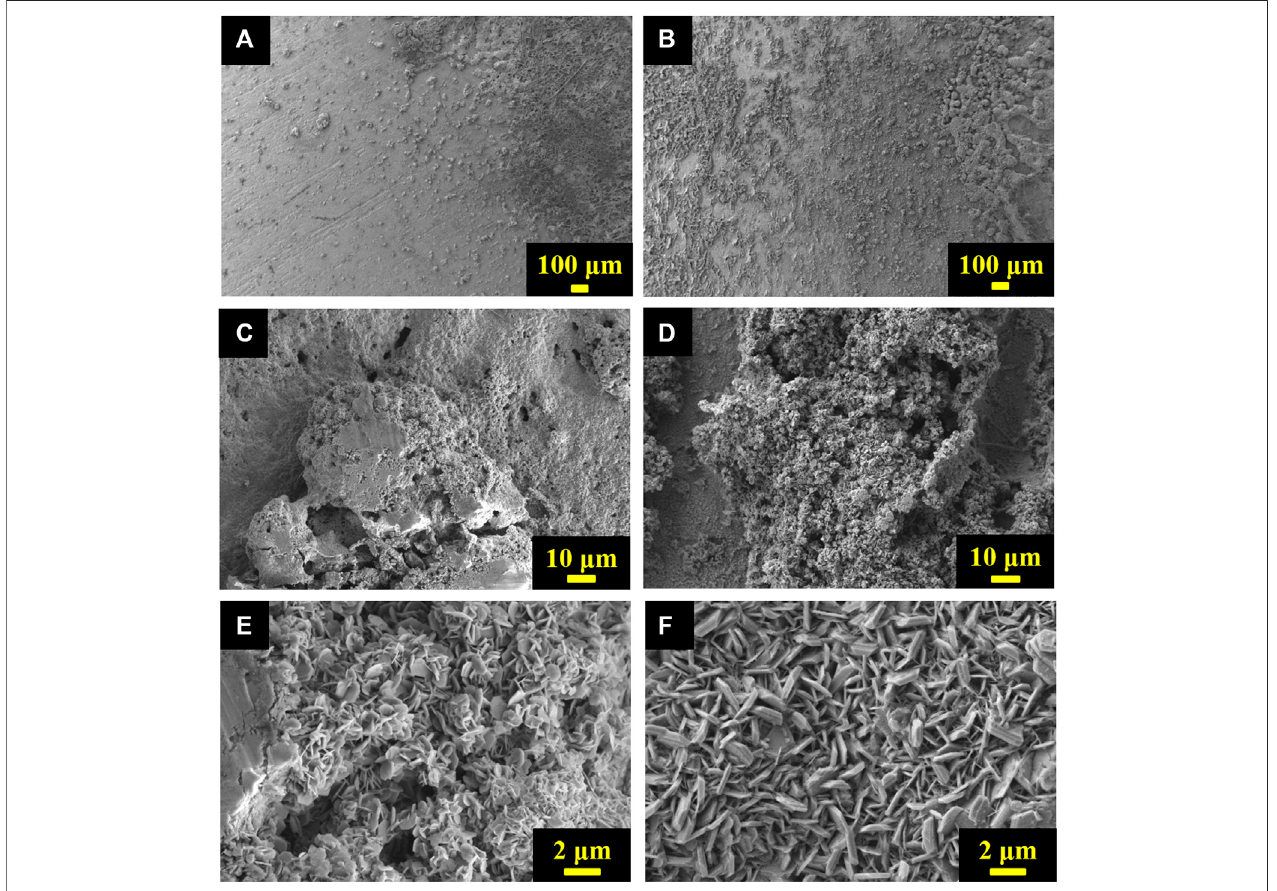
FIGURE 5 | SEM images of cycled Zn anodes (A,C,E) without TPAH and (B,D,F) with TPAH additive at different magni fi cations.